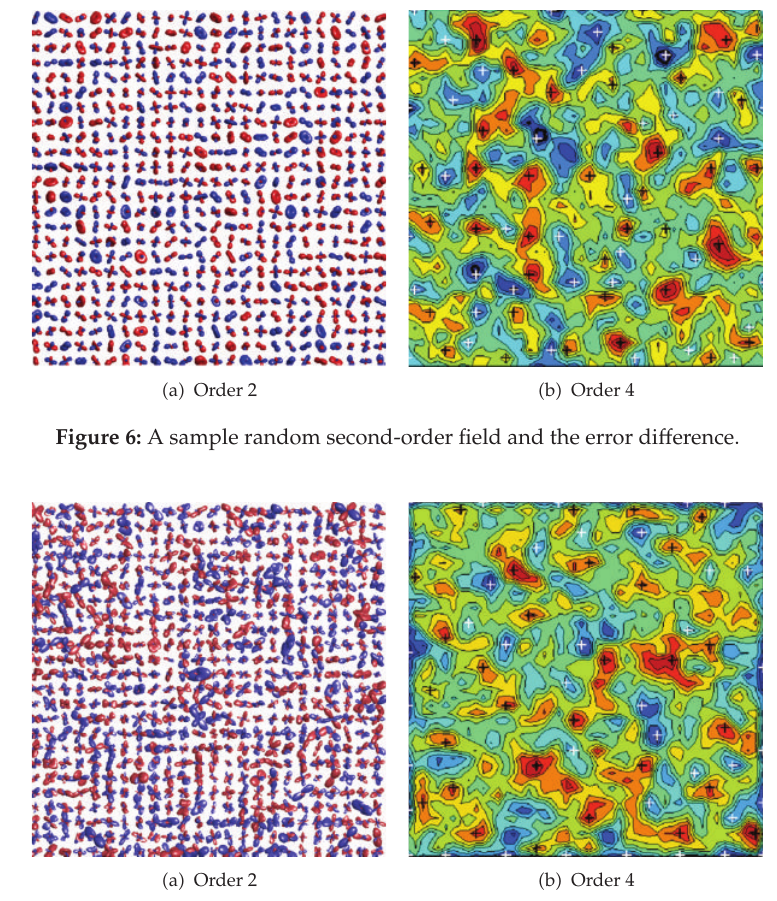
Figure 7: A sample random fourth-order field and the error di ff